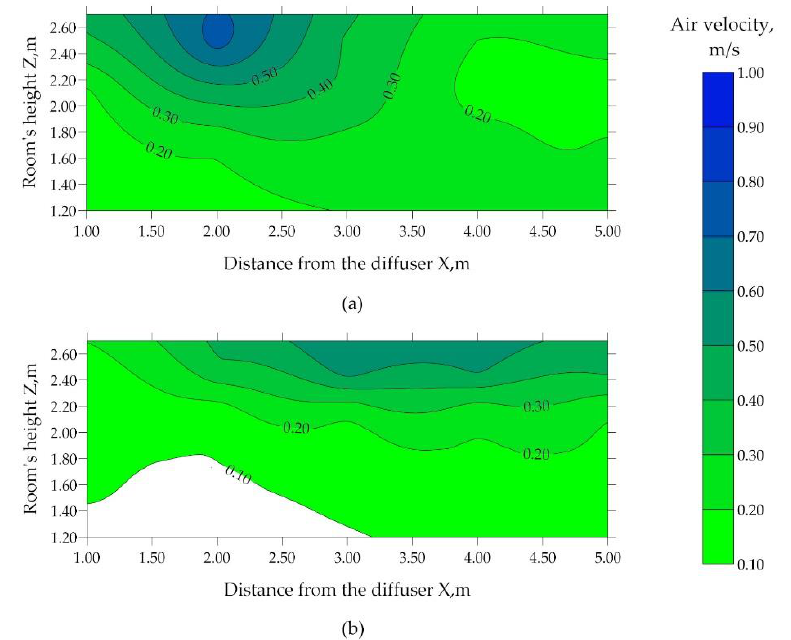
Figure 9. Isolines of air velocity distribution from the supply air for Y = 0.15 m: ( a ) diffuser Type I; ( b ) diffuser Type II.